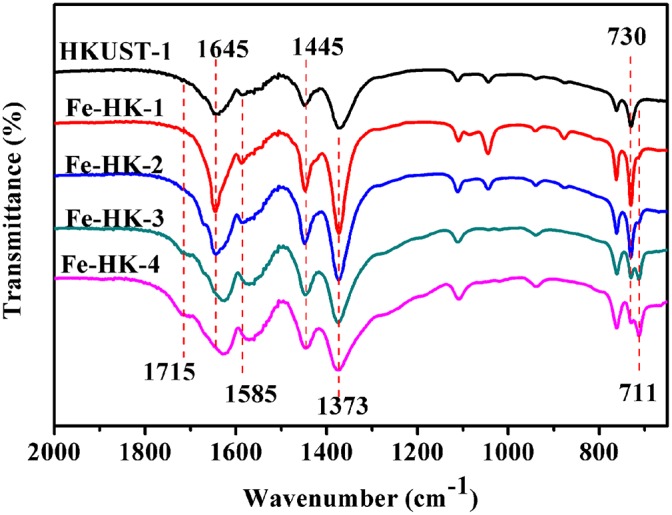
FTIR spectra of HKUST-1 and Fe-HK samples.